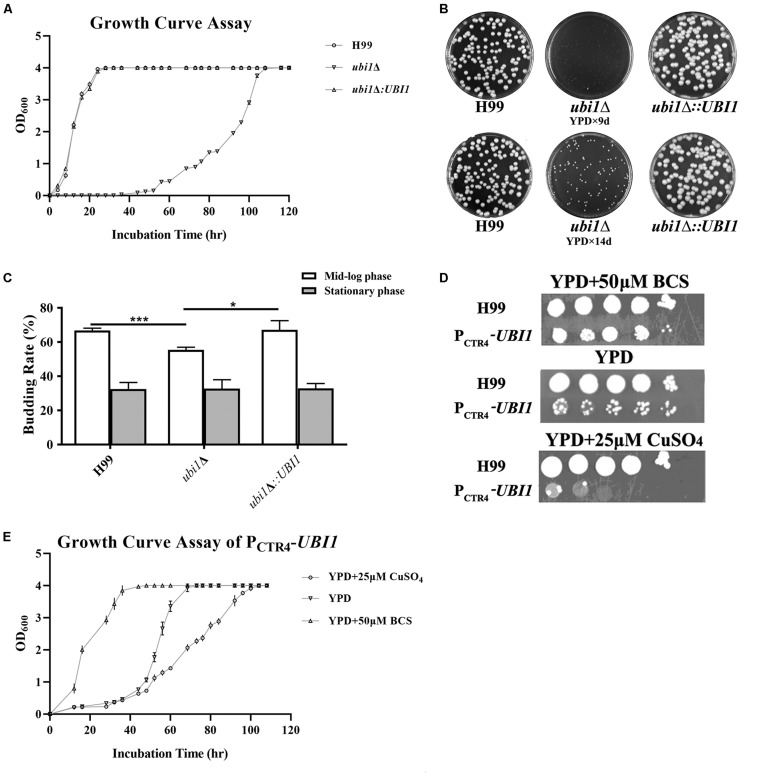
Ubi1 is essential for growth and proliferation in C. neoformans. (A) Growth rate assay. Samples (106 CFU) of the wild-type (WT, H99), mutant (ubi1Δ), and reconstituted (ubi1Δ:UBI1) strains were transferred to 30 mL fresh YPD medium in flasks and incubated at 30°C. OD600 was measured for each culture at 4-h intervals. All assays were performed in triplicate. (B) Colony size measurement. Samples (100 CFU) of each strain were spread on YPD agar medium and then incubated at 30°C for 2 weeks. Photographs of each petri dish were taken on day 9 and day 14. (C) Budding rate assay. Each strain was incubated to the mid-log or stationary phase in YPD liquid medium at 30°C. Each culture was diluted and stained with India ink. The budding rates (%) were calculated with a hemocytometer using the formula: budding cells/total cells × 100 for each strain. The total number of cells for each strain was not less than 500, and each test was repeated three times. ***P < 0.001, *P < 0.05. (D) The growth performance of the condition-regulated strain (PCTR4-UBI1) under YPD agar with/without CuSO4 or BCS. The WT and PCTR4-UBI1 mutants were grown to saturation in YPD liquid medium, 10-fold serially diluted, and 5 μL cells spotted on different YPD solid media. The samples were incubated at 30°C for 1 week and then photographed. (E) The growth rate of the condition-regulated strain (PCTR4-UBI1) was inversely correlated with copper concentration and, thus, positively correlated with UBI1 expression level.